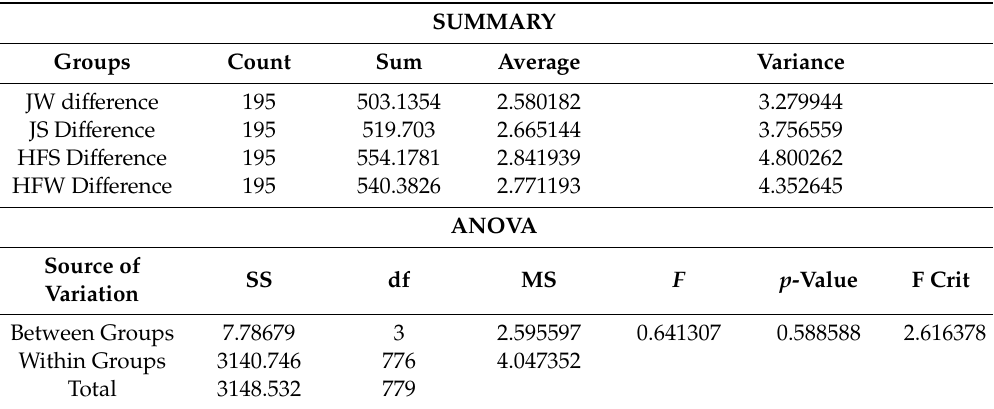
Table A1. ANOVA: Single Factor for Mean with α = 0.05.